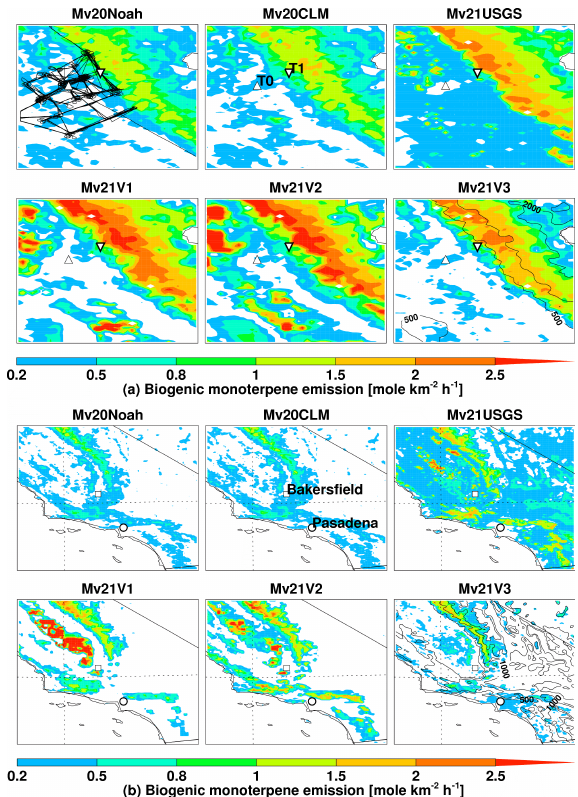
Figure 9. Same as Fig. 8, except for biogenic monoterpene emis-